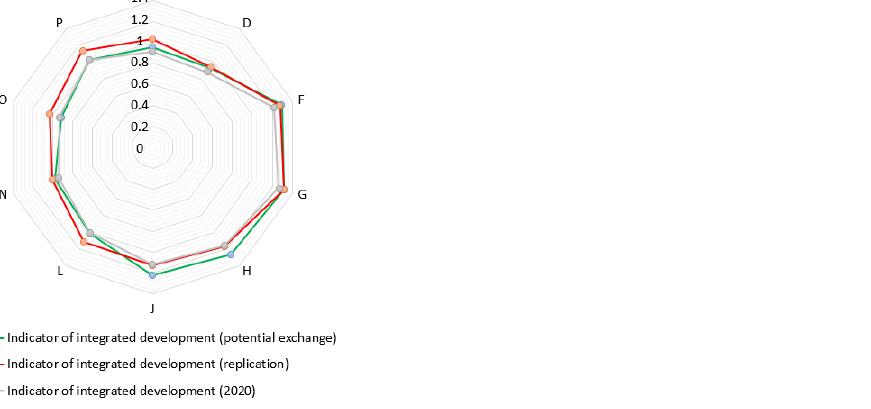
Figure 3. Indicators of integrated enterprise development according to the potential exchange approach and the replication model. Source: Formed by the